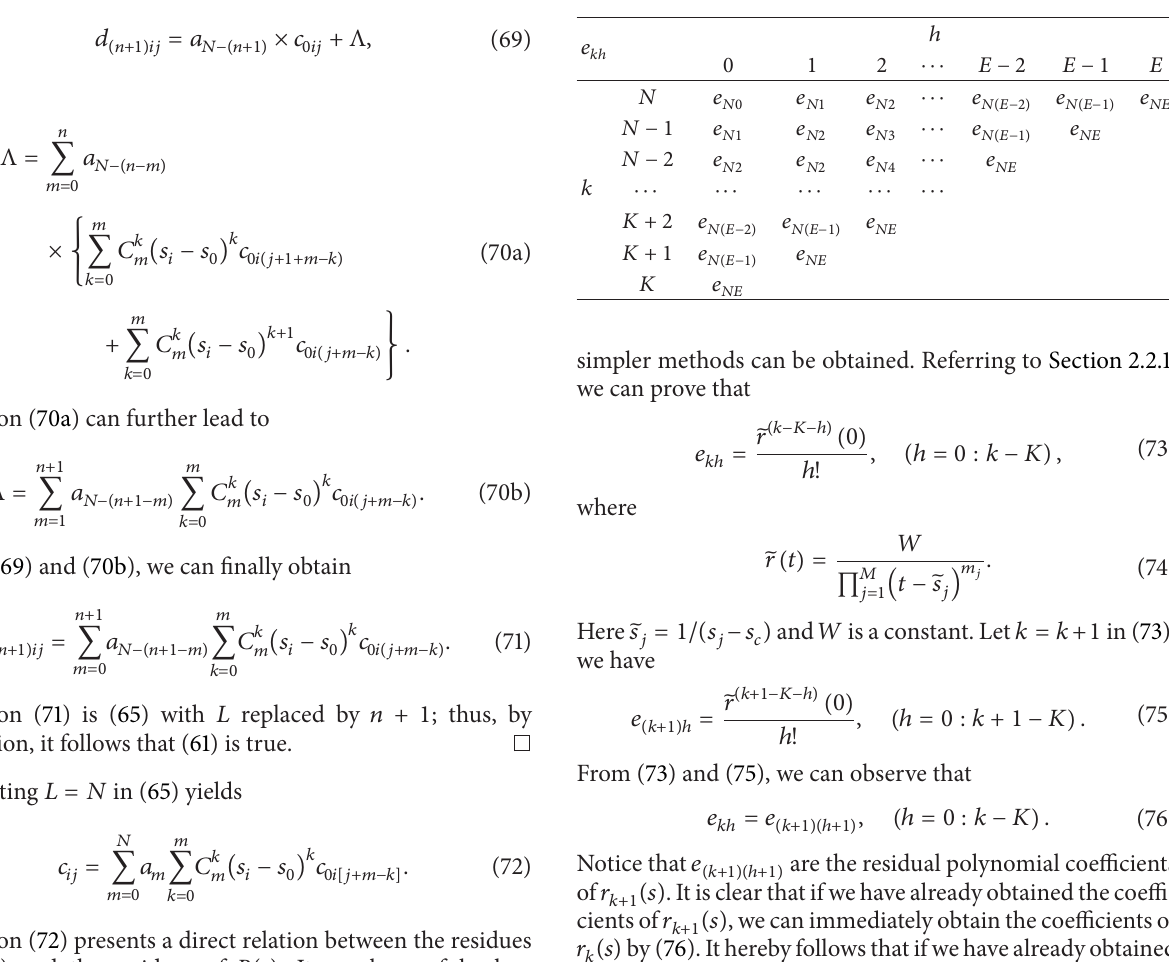
Table 1: The relationship between the 𝑒 𝑘ℎ ( 𝑘 < 𝑁 ) and 𝑒 𝑁ℎ